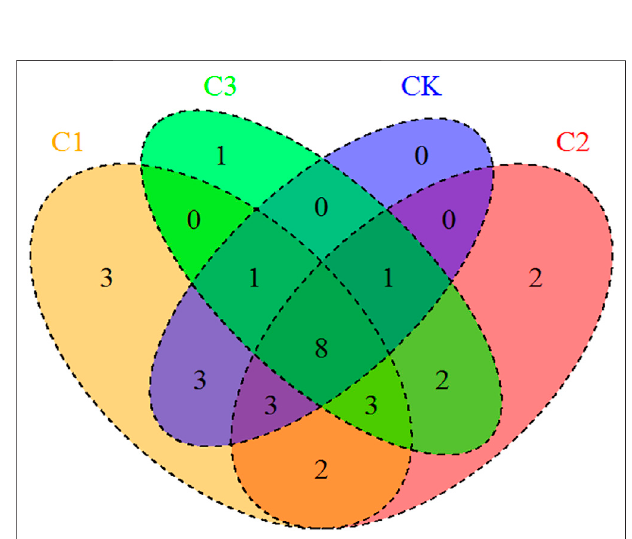
FIGURE 2 | Venn diagram displaying the similarities in soil nematode genera exposed to varying magnitudes of microplastic pollution. CK: no microplastic added to the soil; C1:75 g of microplastics added to the soil (0.5%, w/w); C2: 150 g microplastics added to the soil (1%, w/w), and C3: 300 g of microplastics added to the soil (2%,